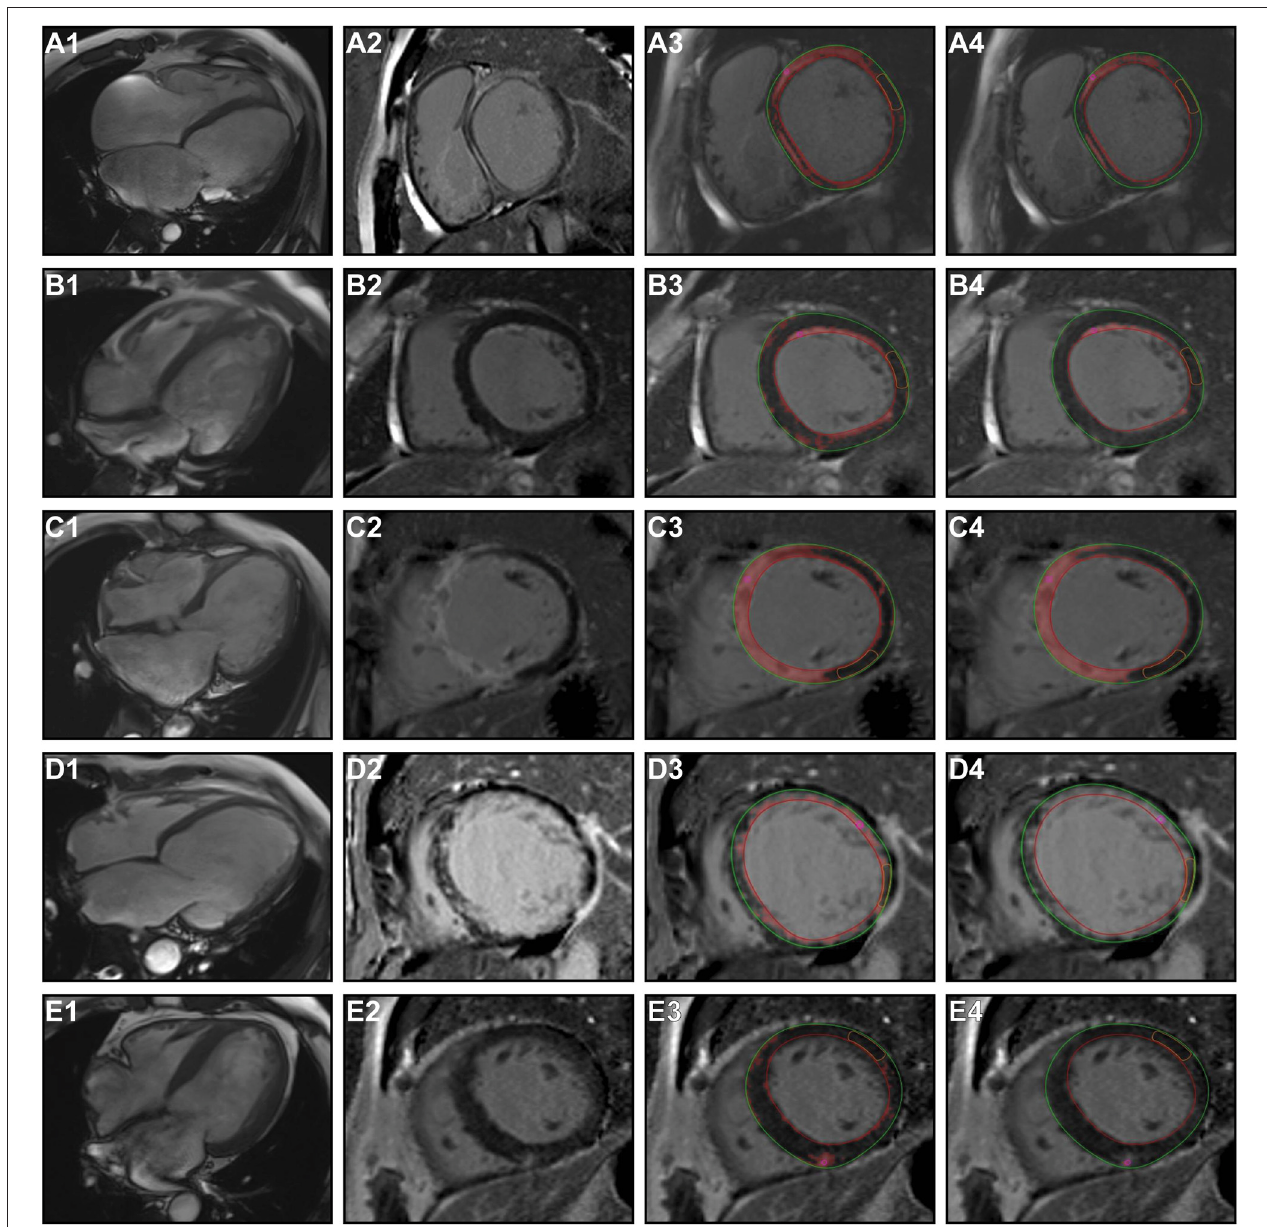
FIGURE 1 | Different patterns and distributions of LGE in patients with end-stage heart failure. The first panel shows the four-chamber view of the heart, the second panel displayed the patterns of LGE. The 2SD and 6SD algorithm quantitative assessments of myocardial fibrosis are marked in the third and fourth panels. Rows A through E depict mid-wall, endo-myocardial, transmural, diffuse, and patchy enhancements in the short axis. LGE, late gadolinium enhancement; SD , standard